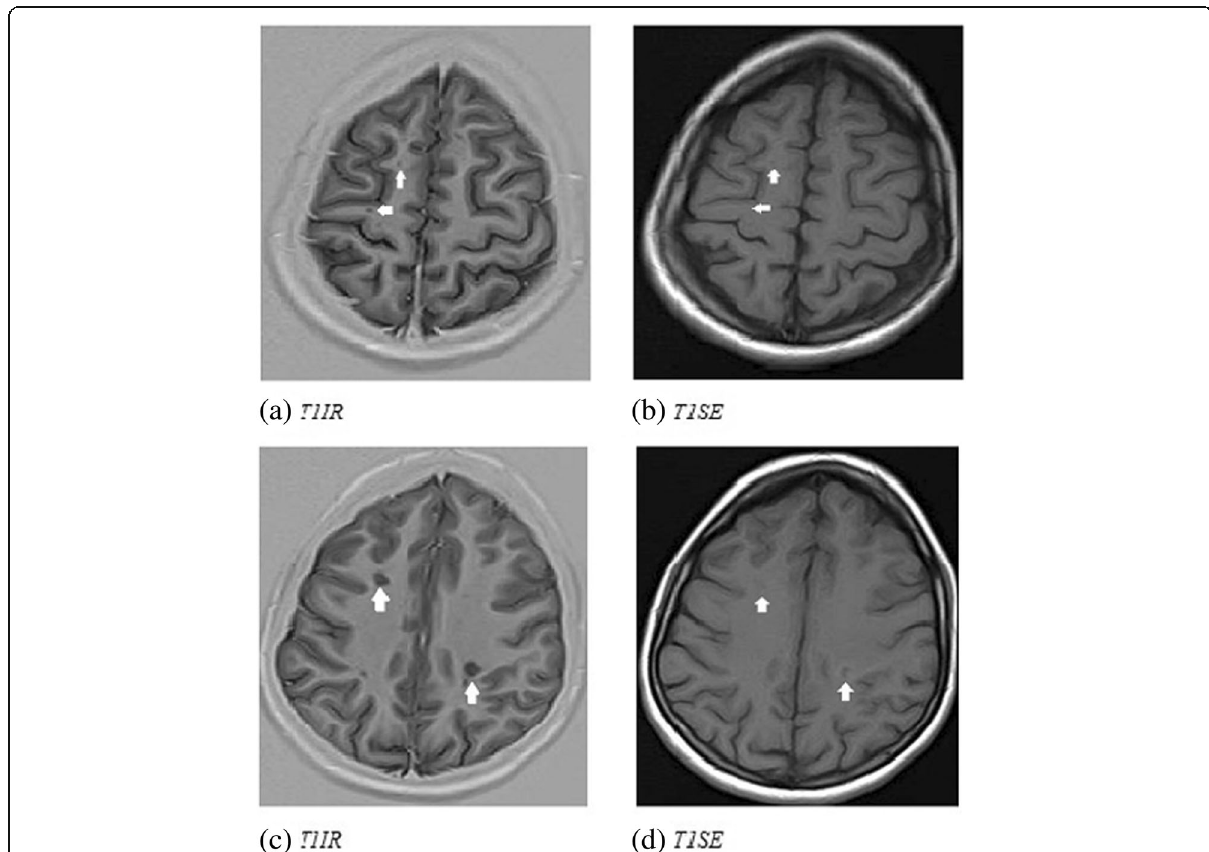
Fig. 4 Known case of multiple sclerosis for follow-up. a T1IR. b T1SE. T1IR aided in the detection of juxtacortical black hole lesions (arrows in a ) that were not detected in T1SE (arrows in b ). c T1IR. d T1SE. Hypointense black hole lesions were better identified and delineated in T1IR (arrows in c ) than in T1SE (arrows in d )